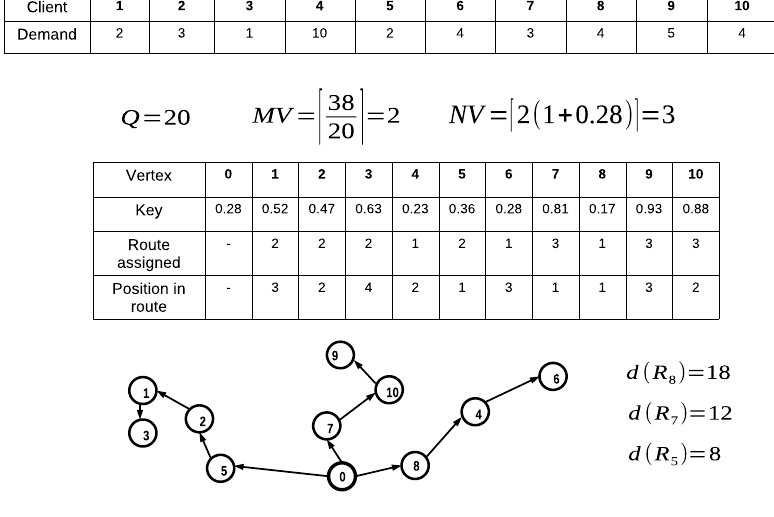
Figure 2. Route decoder